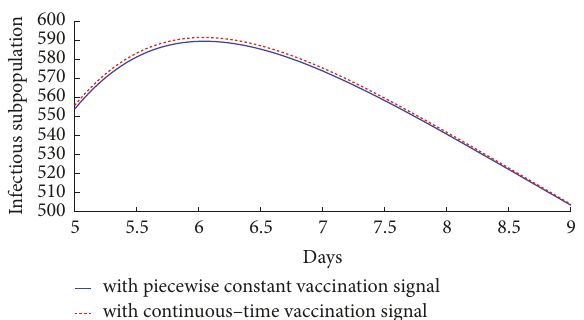
Figure 14: Infectious subpopulation in the SISV model with two different vaccination signals: (i) piecewise constant signal taking integer values and (ii) continuous-time signal.